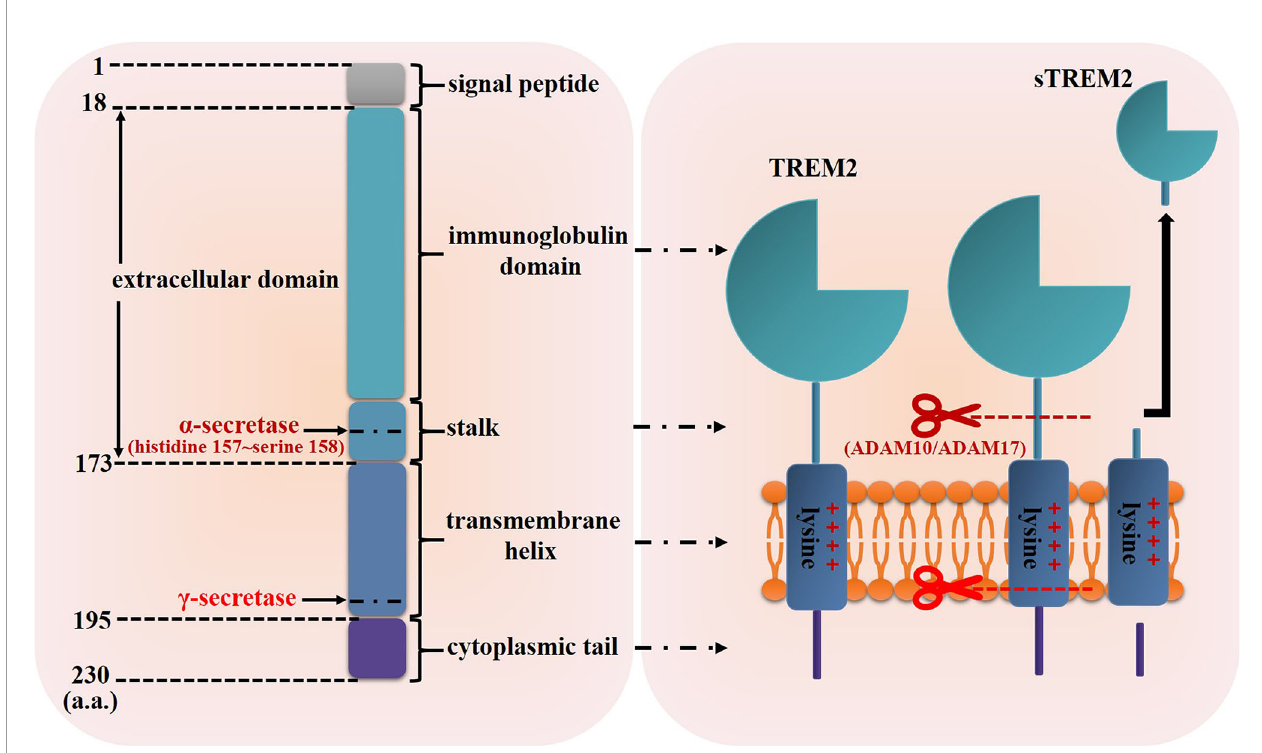
FIGURE 1 | Schematic representation of TREM2 structure. The structure of TREM2 protein mainly includes the signal peptide, extracellular domain which contains an immunoglobulin domain and a short stalk sequence, transmembrane helix and cytoplasmic tail. The a -secretase such as ADAM10 and ADAM17 can cleave TREM2 protein at histidine 157~serine 158 and release sTREM2, then the resultant transmembrane segment undergoes further proteolytic cleavage by g